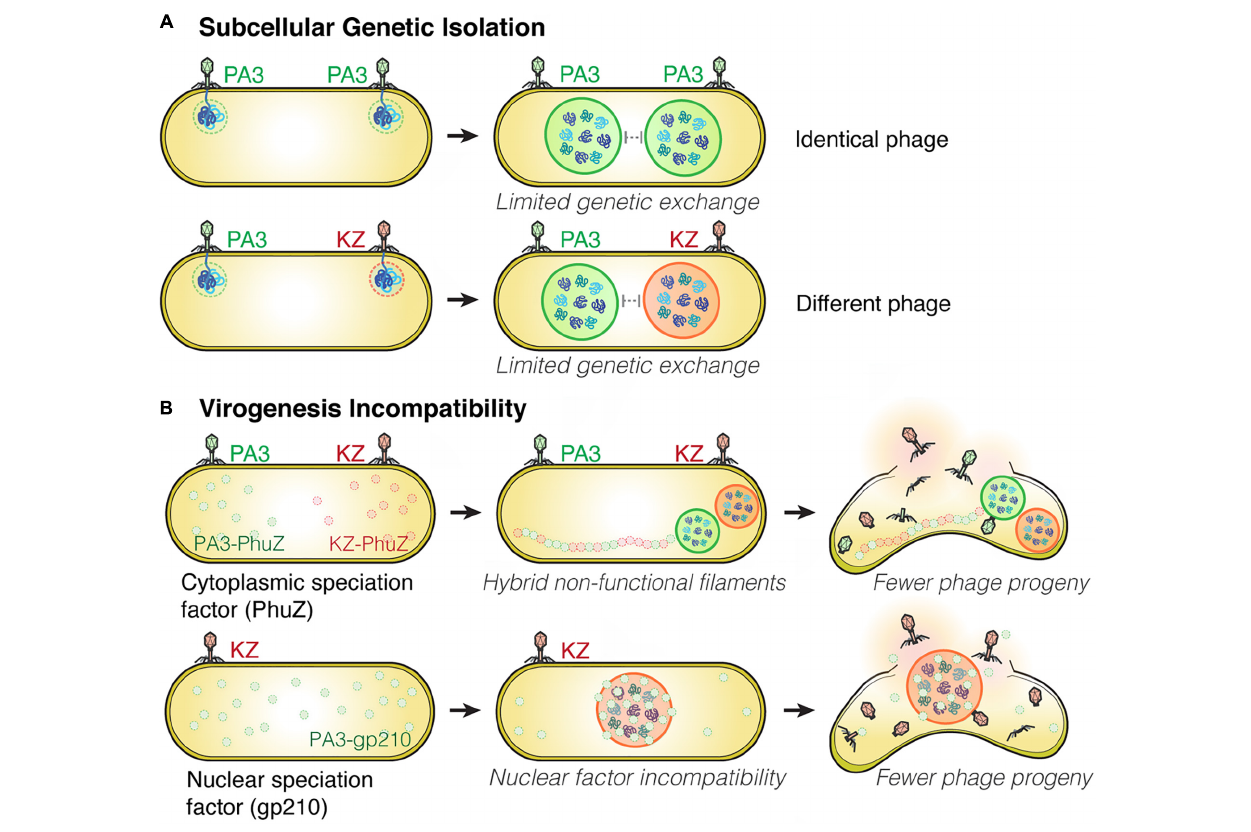
FIGURE 2 | Subcellular Genetic Isolation and Virogenesis Incompatibility contribute to viral speciation. (A) During co-infection by either identical (such as two PhiPA3) or different phages (PhiPA3 and PhiKZ), each individual phage assembles its own compartment that physically separates its genome from another, resulting in Subcellular Genetic Isolation. In both cases of co-infection, with phages that are either identical or different, the shell potentially limits genetic exchange promoting evolutionary divergence. (B) Virogenesis Incompatibility occurs when divergent components of phage replication interact negatively, causing interference with viral replication, such as PhuZ (a cytoplasmic speciation factor) and gp210 (a nuclear speciation factor). This incompatibility results in a reduction in phage fitness (Chaikeeratisak et al.,